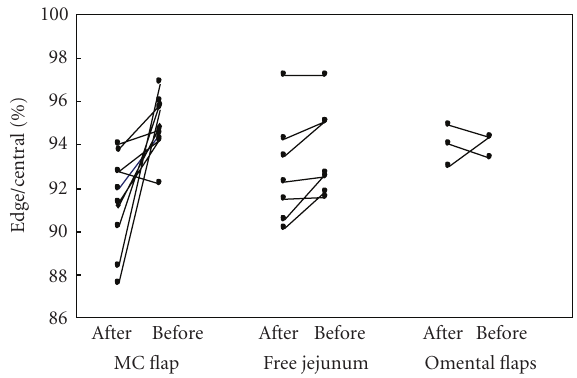
Figure 5: Blood flow ratios between the edge of flap to the flap center in a musculocutaneous (MC), jejunal and omental flaps, before vascular separation and after sewing the flaps.